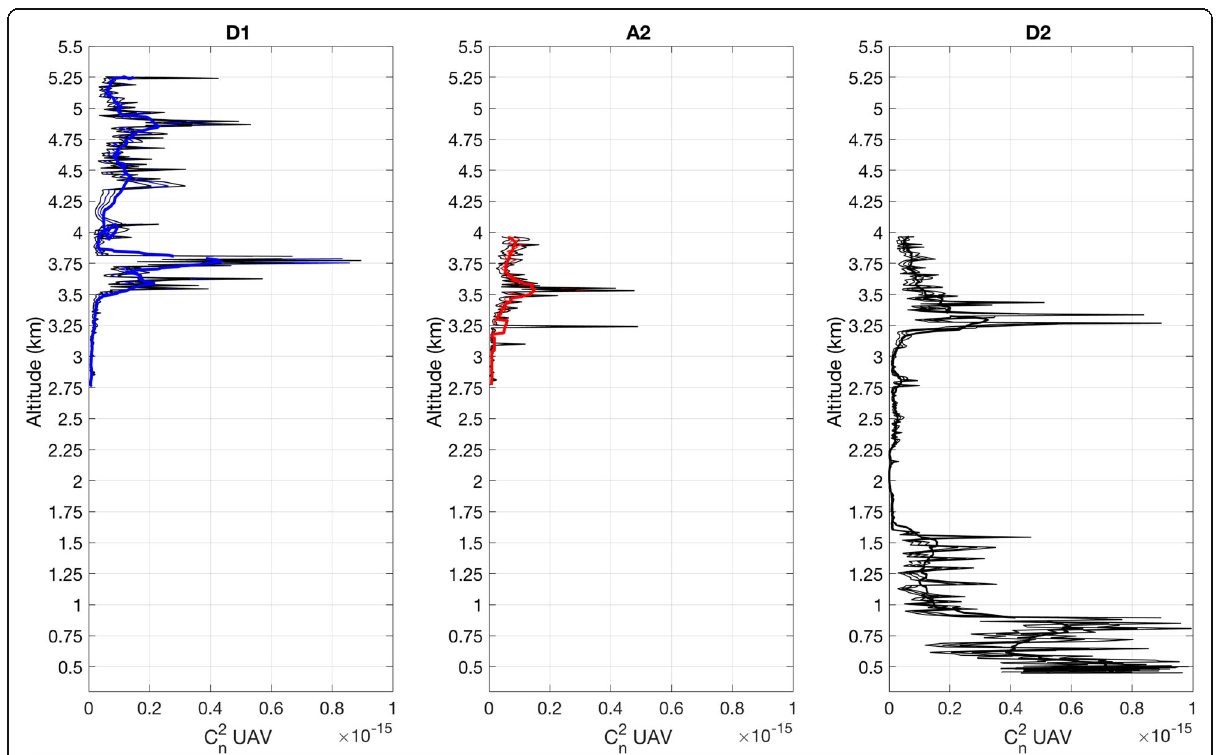
thick lines show the 11-point running mean values. The C 2 and ε values are comparable in magnitude. The UAV T bottom panel shows the UAV altitude as a function of time. This plot should be examined along with Fig. 5b, which shows atmospheric structures detected by the radar, along with the UAV trace. The decaying MCT and CBL regions can be clearly seen. The highly variable levels of turbulence within these structures can also be seen in this plot. In Fig. 15 and subsequent figures, the unit of C 2 is K 2 m -2/3 . The unit o f ε in all figures is W kg -1 . T Figure 16 shows the vertical profiles of the 11-point during D1, A2, and D2 (thick running mean of ε UAV blue, red, and black lines, respectively), whereas the thin blue, red, and black lines (barely visible) show the mean values. The thin black lines in each of the three panels show the upper and lower limits, the difference between the two indicating a measure of the degree of uncer- tainty in dissipation rate estimates. During D1, the UAV managed to sample a region of high-level turbulence be- tween 5.35 and 4.5 km, where the running mean ε UAV ranges in value between 0.1 and 0.5 × 10 − 3 W kg − 1 . This region can be seen clearly in the radar echo in Fig.